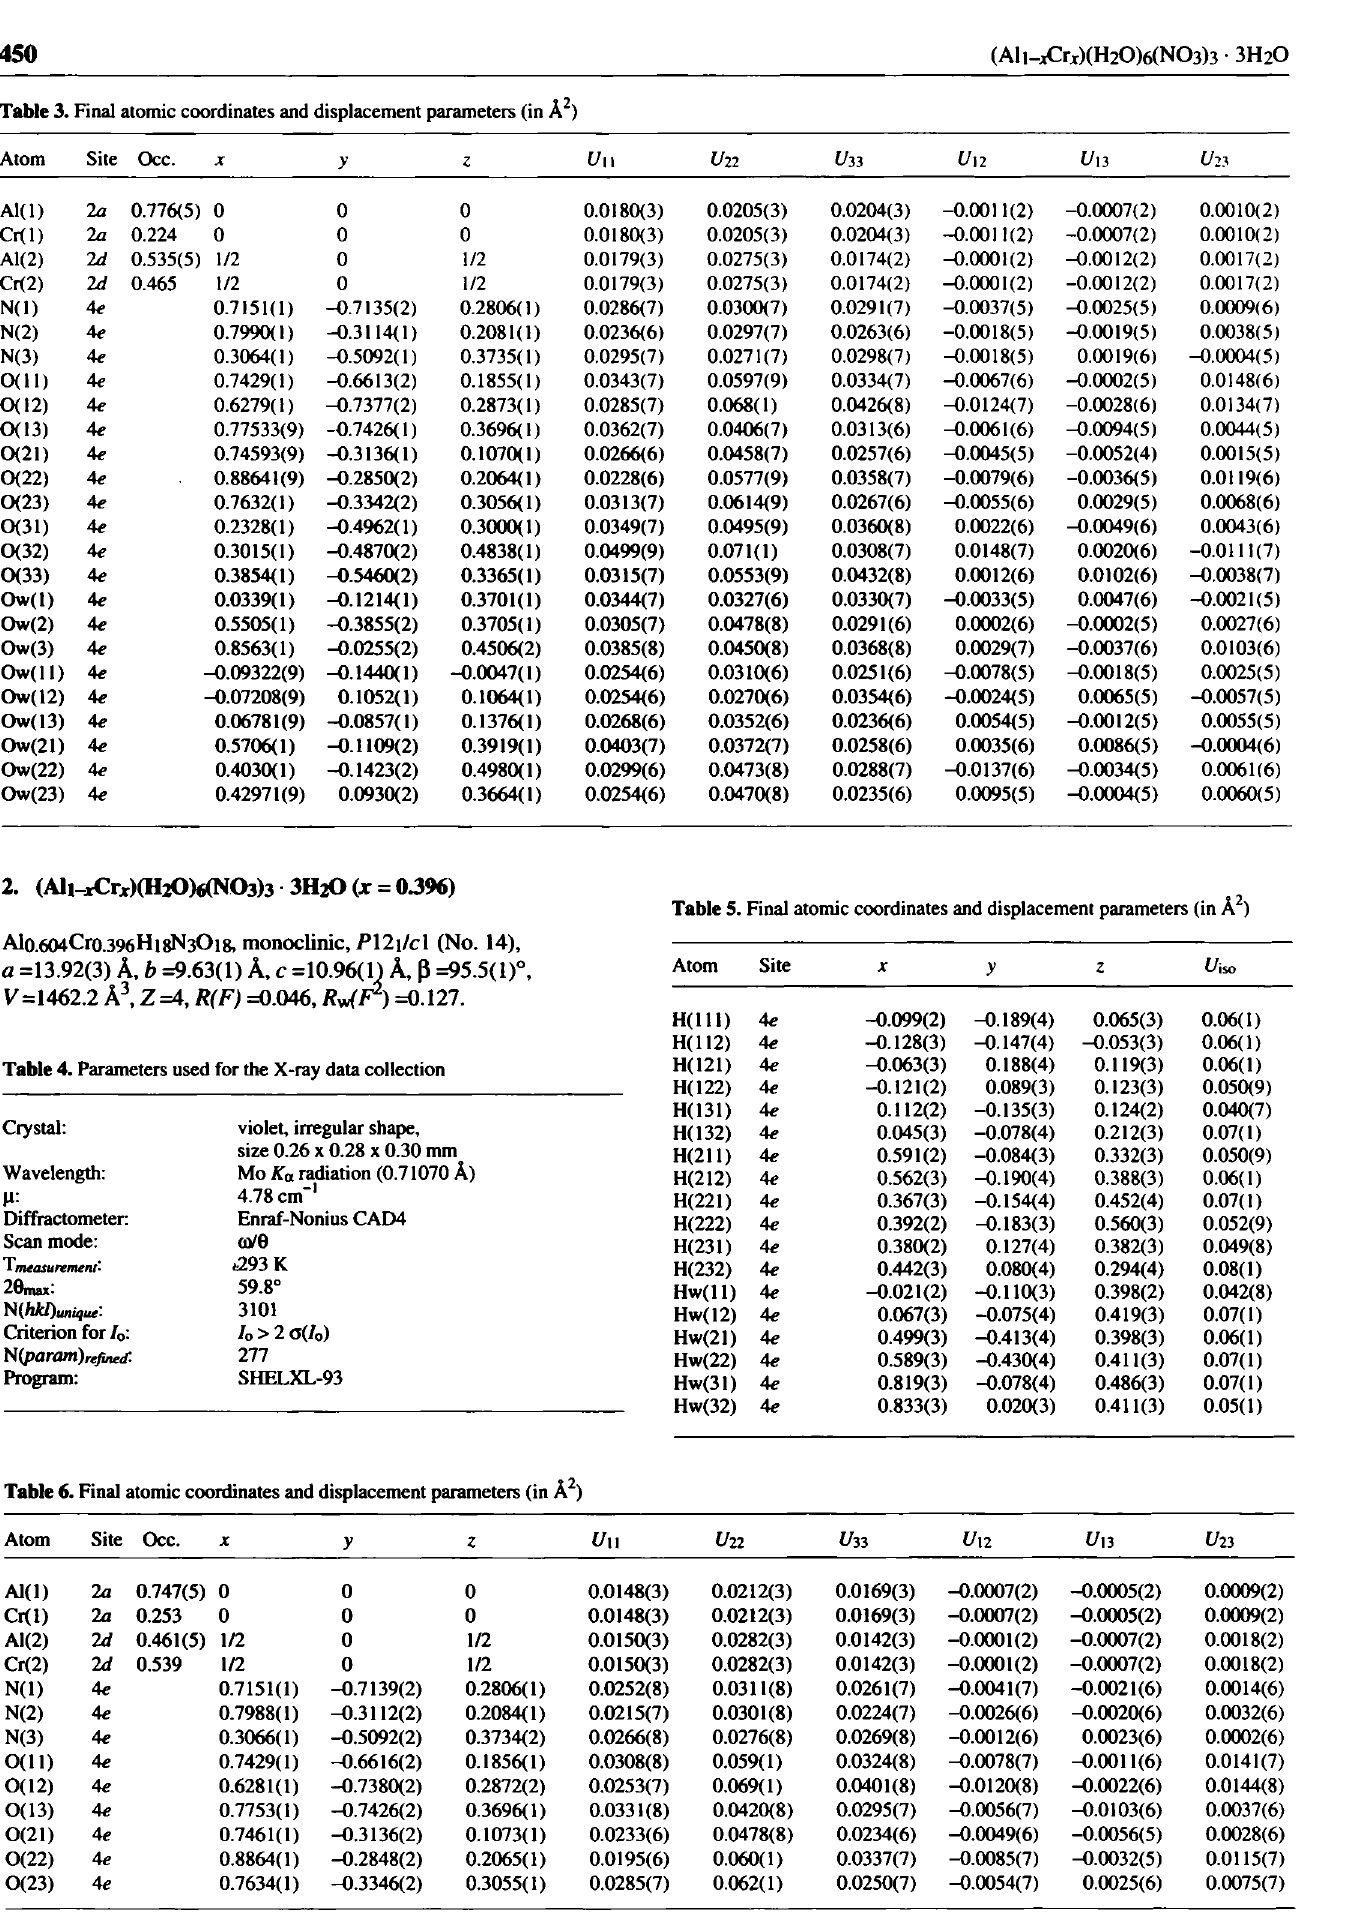
Table 6. Final atomic coordinates and displacement parameters (in